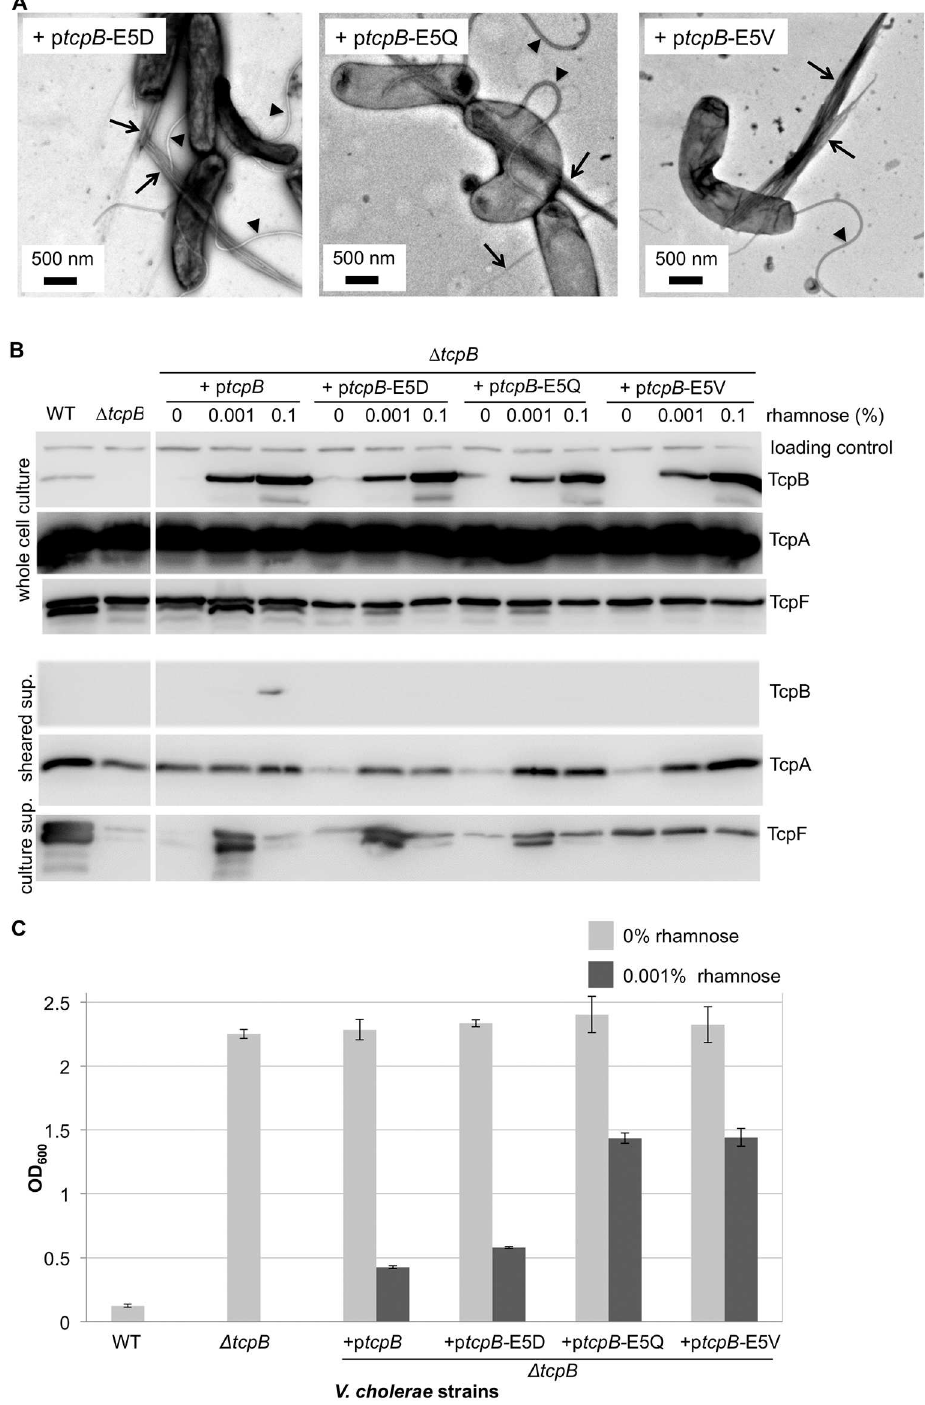
Fig 6. Complementation of V . cholerae Δ tcpB with tcpB -E5V mutants results in impaired autoagglutination and TcpF secretion without disrupting pilus assembly. (A) TEM images of V . cholerae Δ tcpB complemented with tcpB mutants encoding Glu5 substitutions show abundantpilus production. Arrows point to TCP bundles and arrowheads point to flagella. (B) Immunoblotsof V . cholerae fractions for the Δ tcpB strain complemented with WT tcpB or tcpB mutants. TcpF secretionis disruptedfor the TcpB Glu5 variants despitethem producingTcpB levels comparable to that of the WT tcpB -complemented